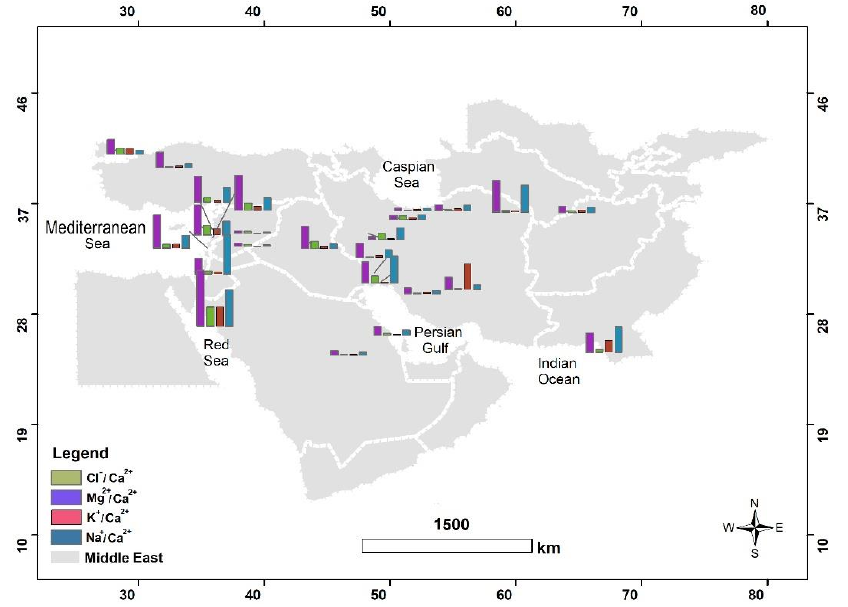
Figure 7. The distribution of major ion ratios in precipitation to Ca 2+ in the studied stations. Furthermore, the SO 42 − /NO 3 − ratio is a good indicator for studying and monitoring anthropogenic sources in precipitation [93]. In the Middle East precipitation, this ratio varies from 0.37 to 21.77, with an average of 3.77. Both SO 42 − and NO 3 − contribute to precipitation acidity by producing H 2 SO 4 and HNO 3 , respectively [94]. At most stations across the Middle East, the SO 42 − /NO 3 − ratio is very low. For instance, at Tehran and Ankara stations, which are affected by severe air pollution, the SO 42 − /NO 3 − ratio is 1.94 and 0.88, respectively. Atmospheric pollution due to fuel combustion in vehicles and the lower usage of other air pollutants, such as coal, result in low SO 42 − /NO 3 − ratios [26]. However, higher values of SO 42 − compared with NO 3 − in precipitation acidity have also been reported in areas where coal is used to provide energy [10,95]. Table 1. The SSF and NSSF of the major ions in the Middle East